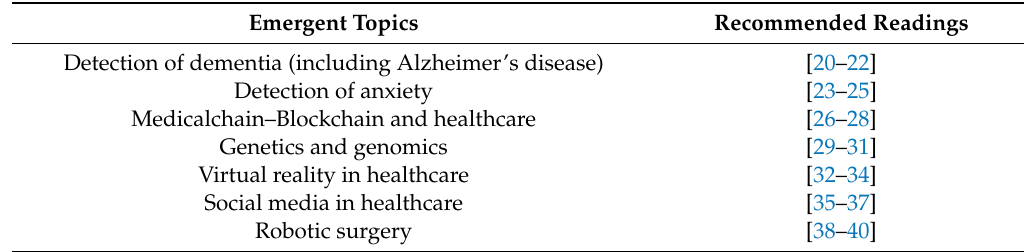
Table 2. Summary on the application and methodology of the special issue